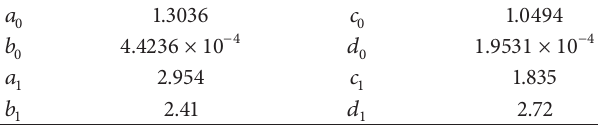
Table 2: Correlation coefficients adopted in this study